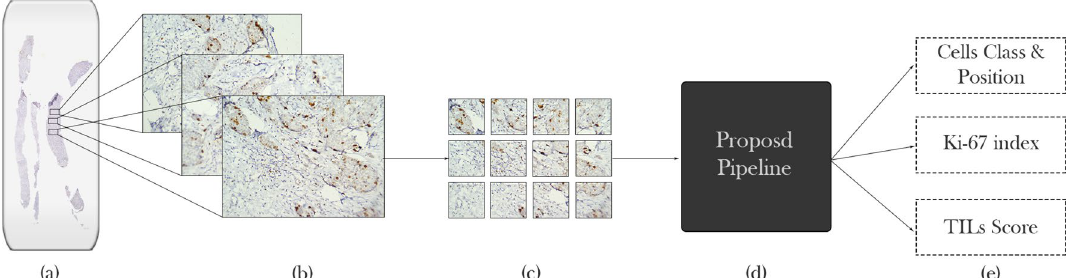
Figure 8. From whole mount slide image preparation to Ki-67 and TILs estimation. The process starts by taking pictures ( b ) from a patient’s tumor section ( a ) and cropping them into 256 × 256 pixels sub-images. Next, each cropped image ( c ) is fed to the proposed pipeline ( d ), resulting in predicted cell centers, corresponding class labels ( e ). Then, the Ki-67 index and TILs score can easily be calculated. Figure 10 depicts a prediction sample image with 4912 × 3684 pixels size.